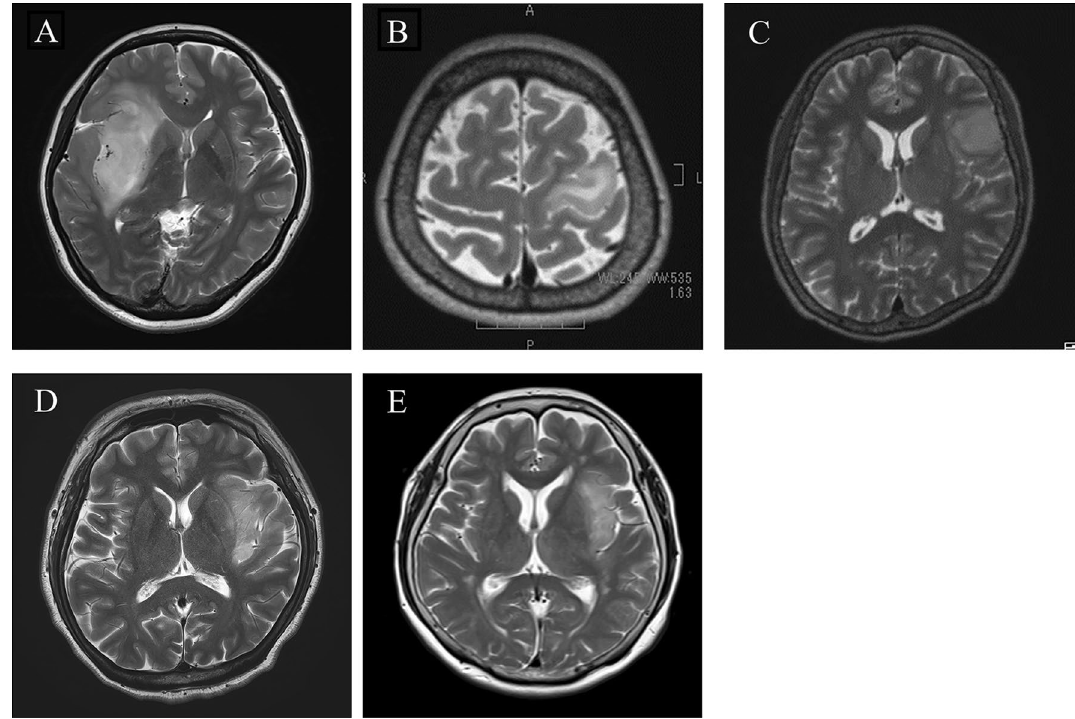
tumor (Case 3) ( C ), of the left insular tumor (Case 4) ( D ) and, of the left insular tumor (Case 5) ( E